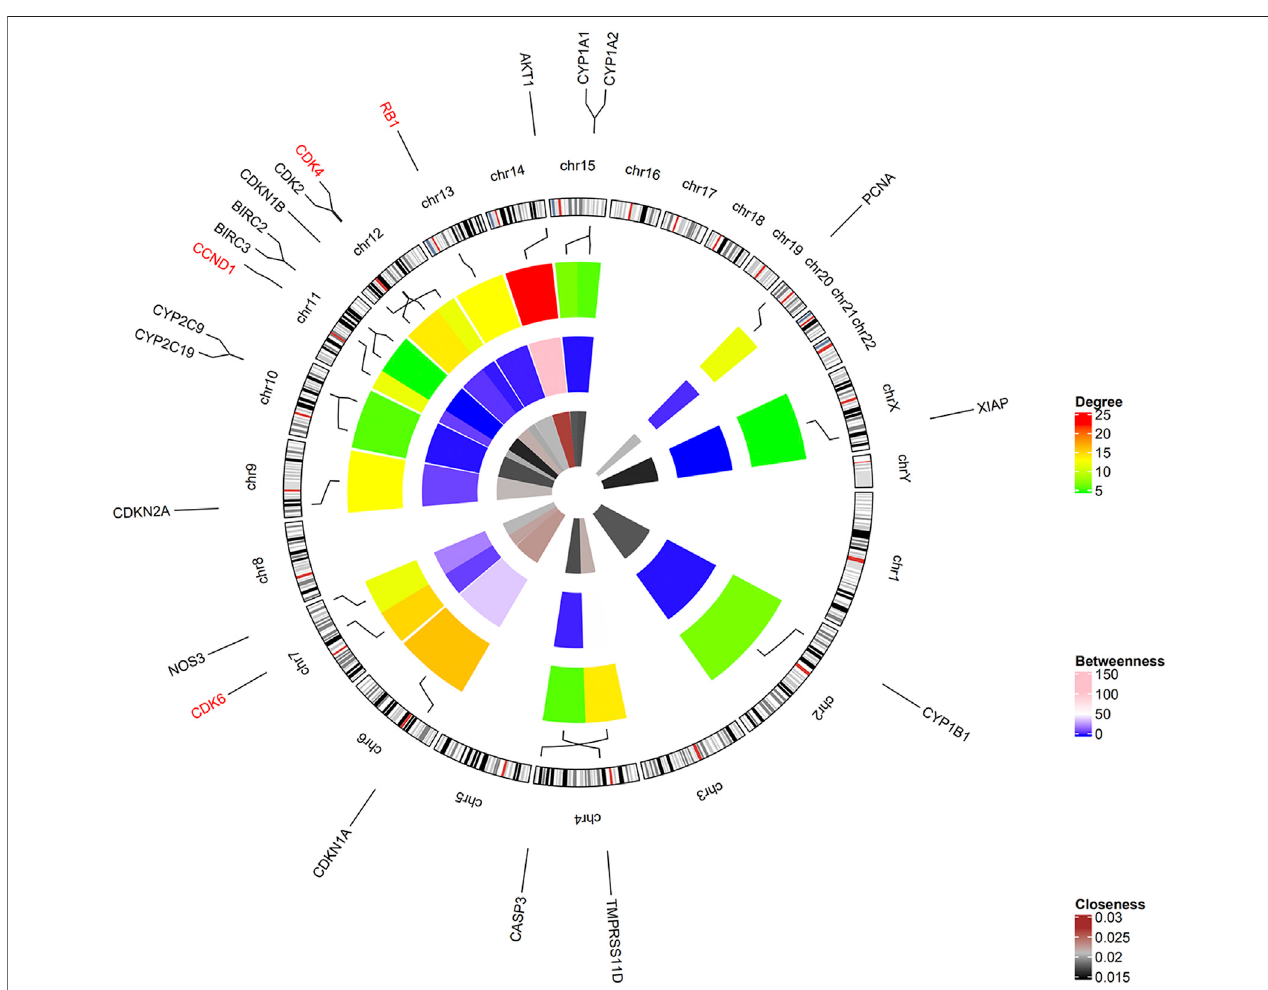
FIGURE 4 | Positions on chromosome and degree centrality information of all the tanshinone-targeted genes. There are three circles of the heatmap. The inner, middle, and outer circles demonstrate closeness, betweenness, and degree information. Hub genes CCND1, CDK6, RB1, CDK4 were located on chr11, chr7, chr13, and chr12,